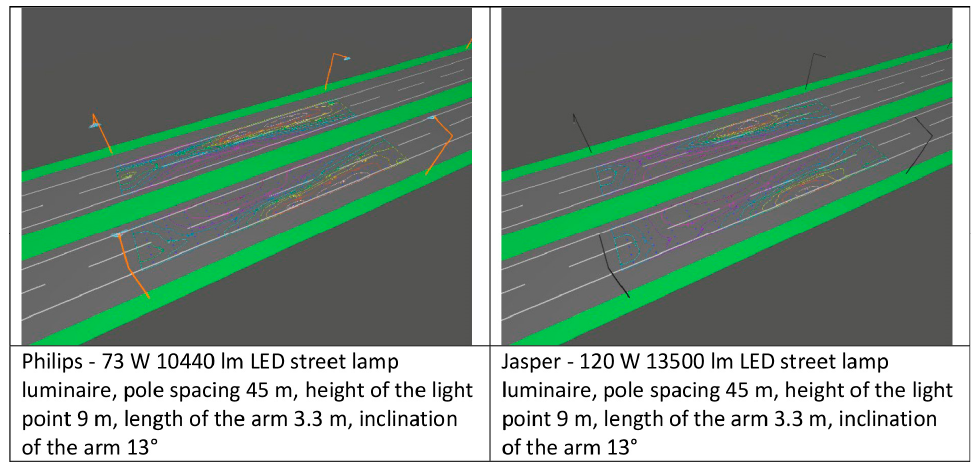
Figure 4. Changes in roadway illumination depending on the luminaires used (source: original work).